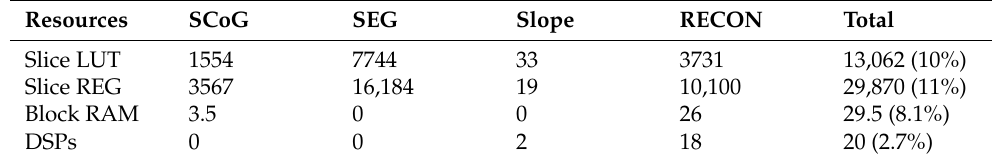
Table 2. Resource usage of different modules on Artix 7 XC7A200T.